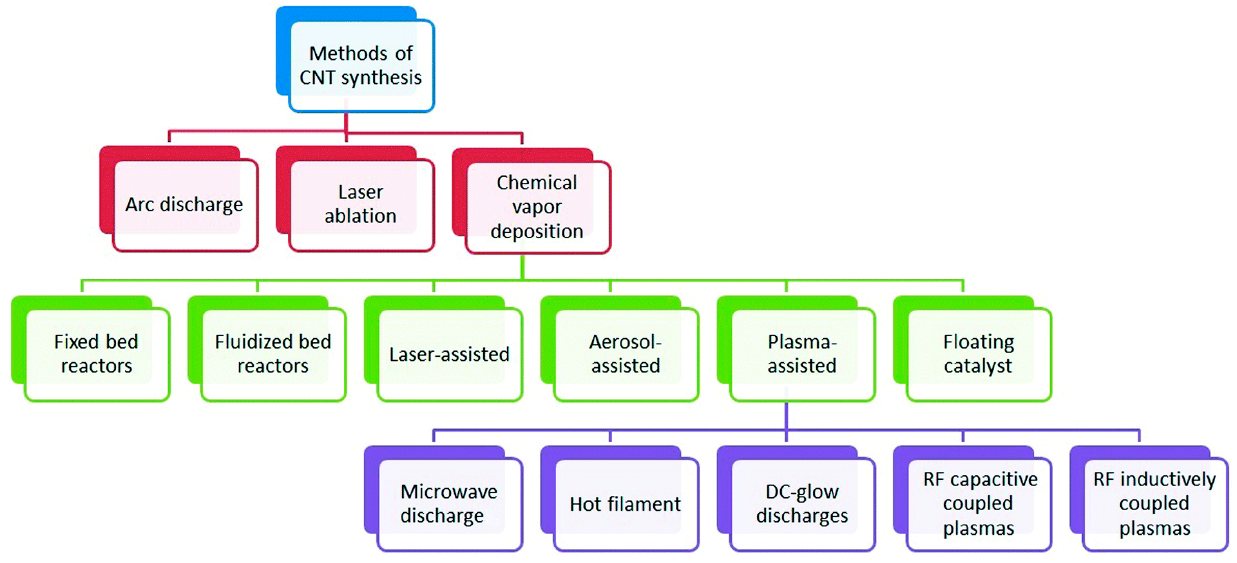
Figure 2. Categorization of synthesis methods used for carbon nanotubes. Adapted from Ref. [49] with Permission from RSC Advances.